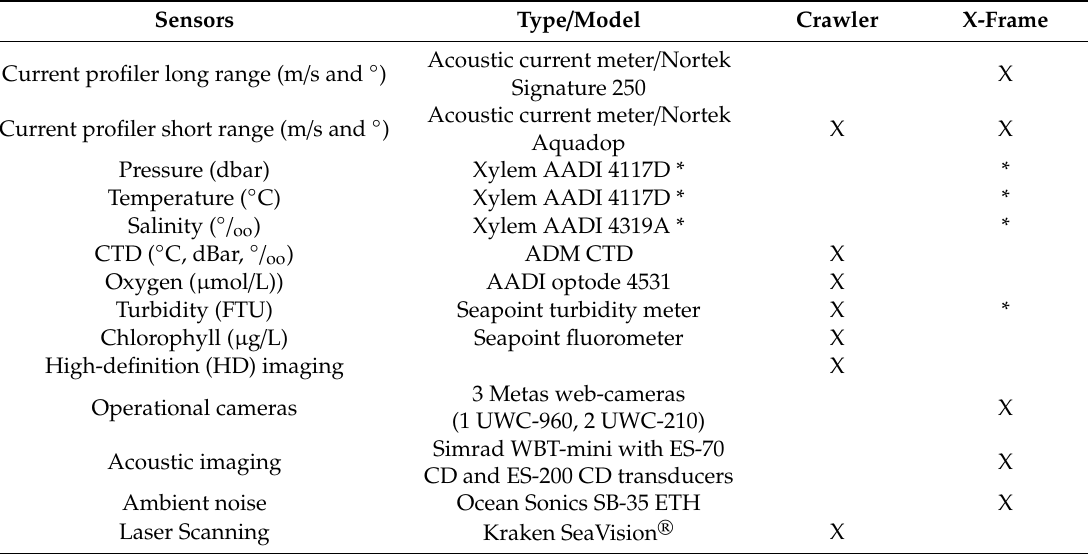
Table 1. The main environmental sensors assets used for ecological monitoring as pursued by